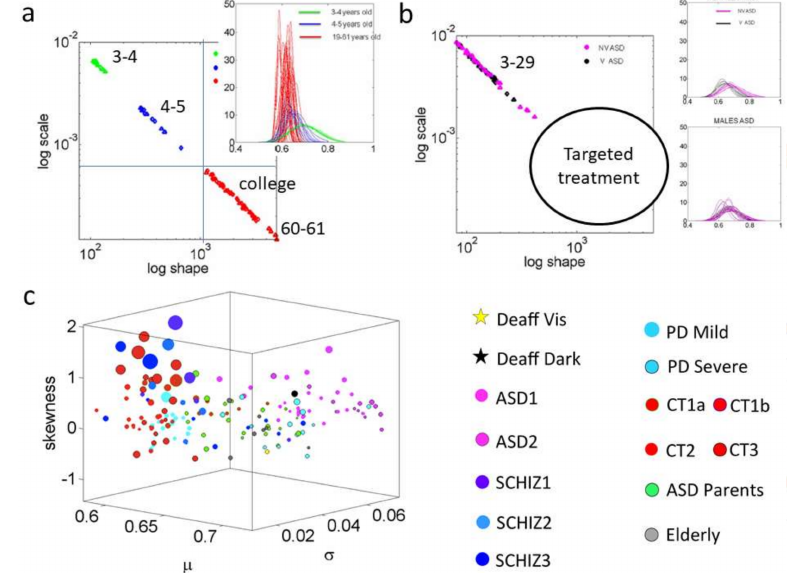
Figure A2. Taken from [3,7]. Mapping disorders of the nervous systems with the SPIBA framework and the micro-movement spikes derived from linear speed time series during continuous pointing behavior. ( a ) Normative cross-sectional data from 3 to 61 years of age demonstrates a maturation process. As age increases for the different participants in different age groups, the shape increases in value and the scale (noise to signal ratio) decreases in value according to a power relation well fit to the log–log scatter by a linear relation. ( b ) There is an absence of the neurotypical maturation process in the stochastic signatures of autism spectrum disorders or condition (ASD) pointing behavior. Regardless of age (3–29 years old), or verbal capacity (verbal and non-verbal), the ASD participants remain in the left upper quadrant (LUQ) with higher noise and more random features (nearing the Exponential distribution). ( c ) Taken from [3]. Localizing autism among other nervous systems